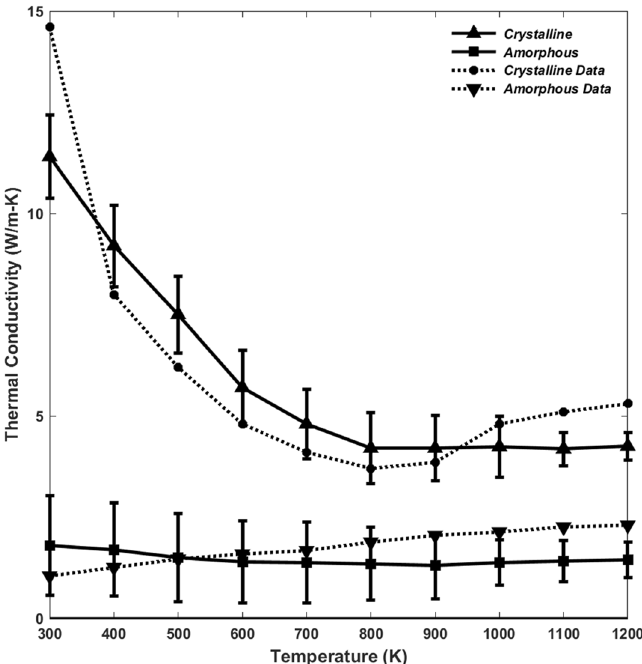
were taken from Ref. 27